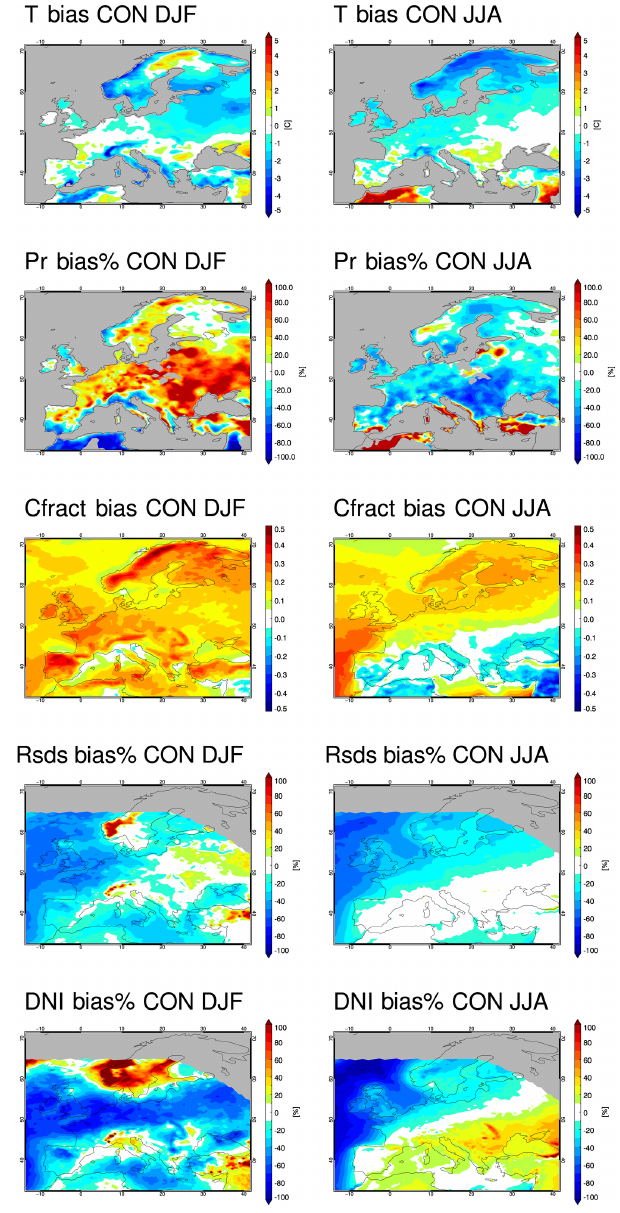
Figure 3. Bias plots for control simulation CON for winter (DJF, left) and summer (JJA, right). Biases depicted from top to bottom for temperature ( T ), precipitation (Pr), total cloud fraction (Cfract), downwelling shortwave radiation to the surface (Rsds) and direct normalised irradiance at the surface